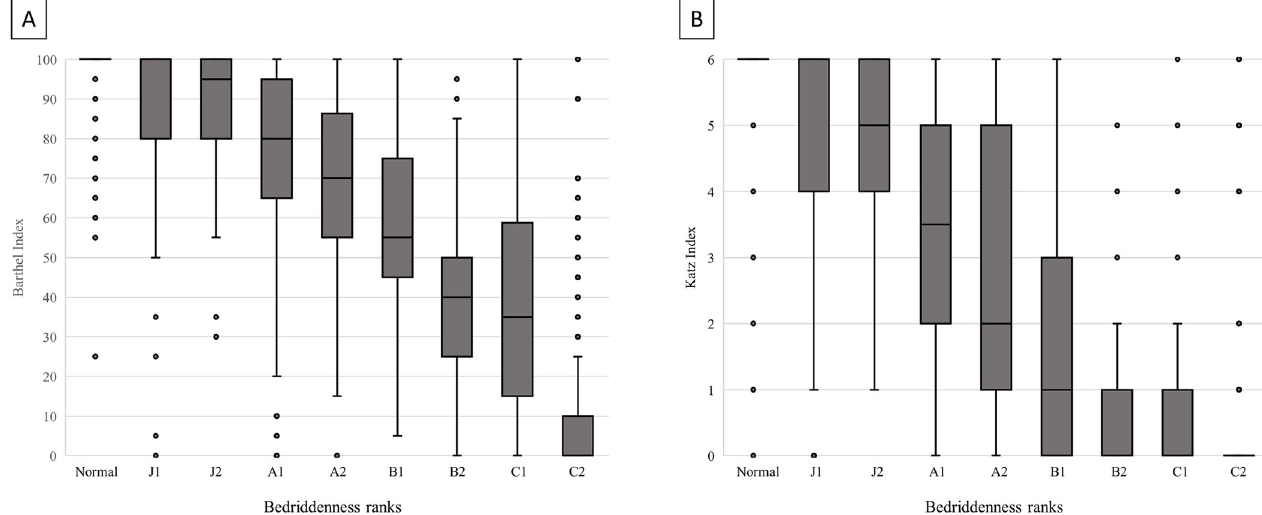
Fig 2. Box and whisker diagrams showing the relationship between BR and (A) BI, and (B) KI. Spearman’s rank correlation coefficient between Bedriddenness Rank and Barthel Index was − 0.891, p < 0.001 (A), and that between Bedriddenness Rank and Katz Index was − 0.877, p < 0.001 (B).